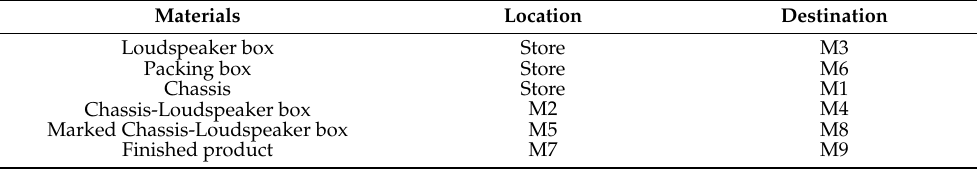
Table 2. The processing station corresponding to the raw material to be processed.